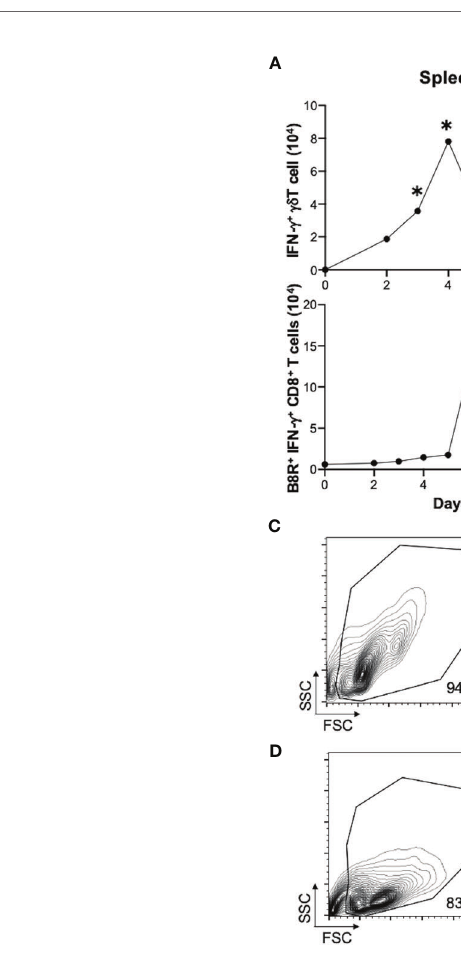
FIGURE 1 | Activation of gd T cells in response to VV infection. 5 x 10 6 pfu of VV were injected into wild-type C57BL/6 mice intraperitoneally. 2, 3, 4, 5, 6, 7 and 8 days after infection, CD8 + T cells from spleen and peritoneal cavity were assayed for IFN- g production by intracellular staining by FACS, and IFN- g + gd T cells and CD8 + T cells from the spleen (A) spleen and peritoneal cavity (B) are shown. IFN- g + gd T cells are fi rst gated on CD3e + and gd TCR + , then assessed on IFN- g expression. VV-speci fi c B8R + IFN- g + CD8 + T cells were fi rst gated on B8R + CD8 + T cells, and then assessed for IFN- g expression. The mean of each time point is plotted. Representative of 2 independent studies, each with 3 biological replicates. Gating strategy used to generate the data are represented by (C, D) . The gating for IFN- g + gd T cells is determined against IFN- g + gd T cells from control naïve mice for each experiment. Mann-Whitney test, * P <